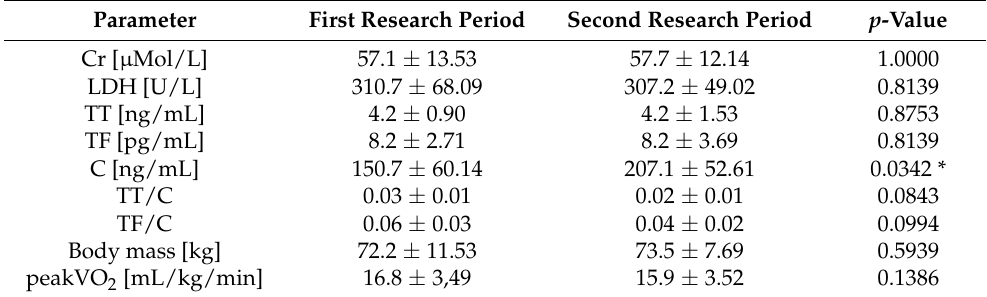
Table 3. Basic characteristics (x ± SD) of physiological and biochemical parameters measured in first and the second research